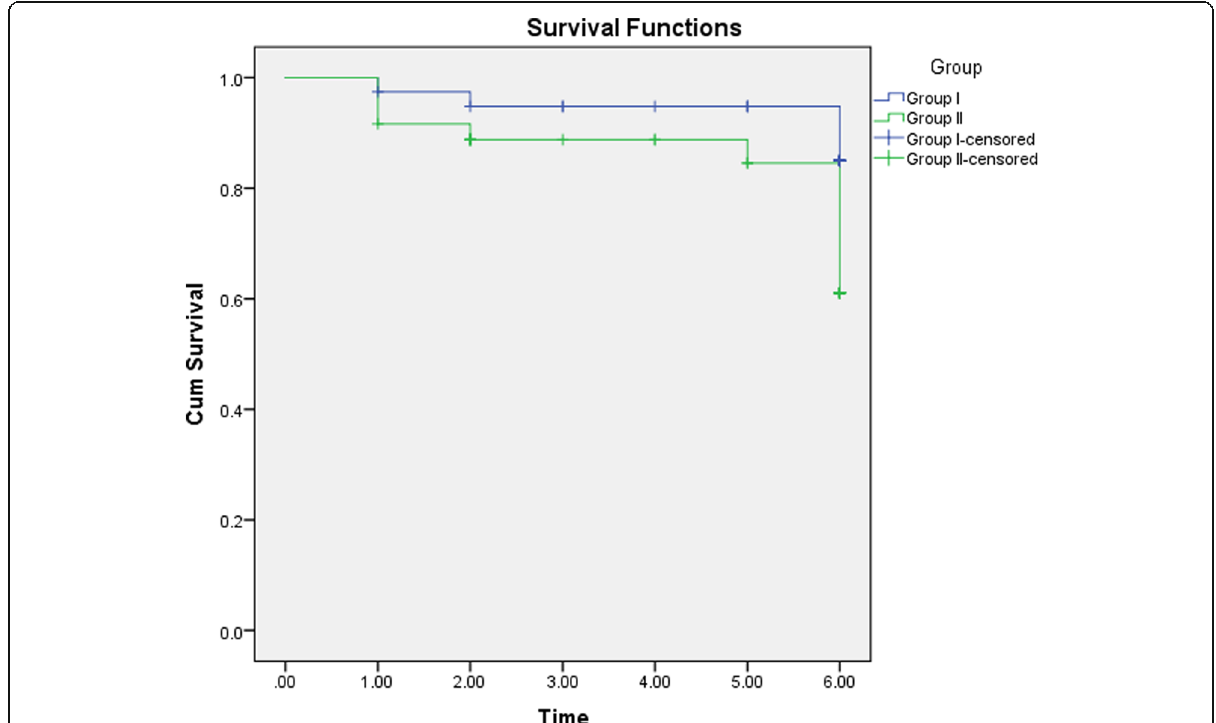
Fig. 2 Disease free (SBP free) survival (in months) by Kaplan-Meier analysis at 6